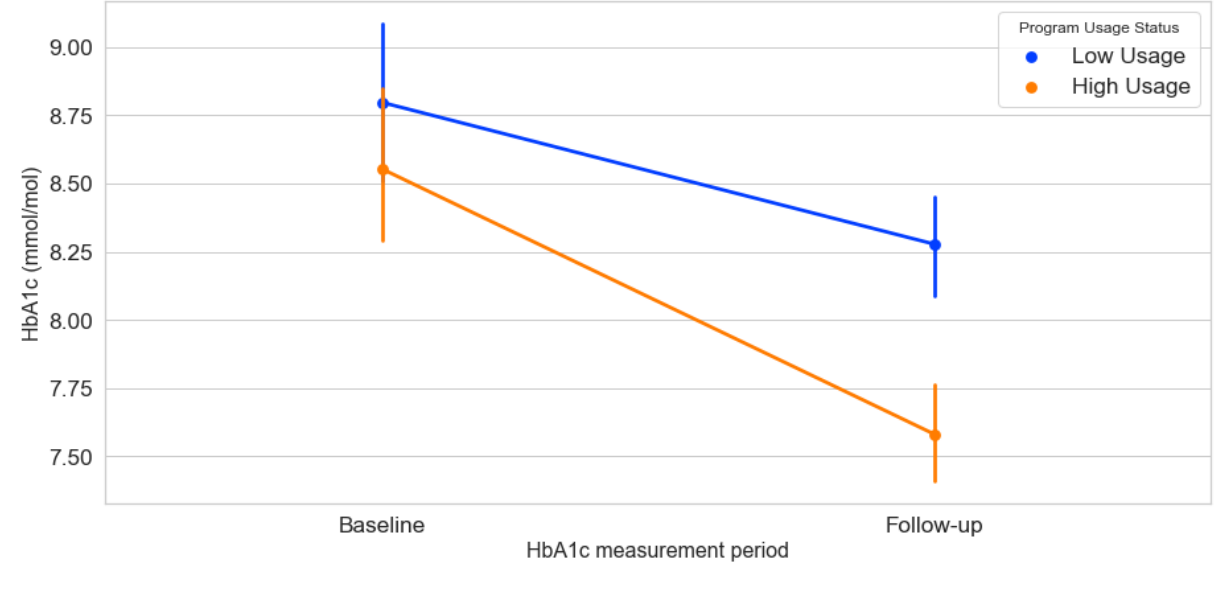
Figure 7. Estimated marginal means of HbA 1c at Program start (baseline) and at follow-up as a function of high and low program usage